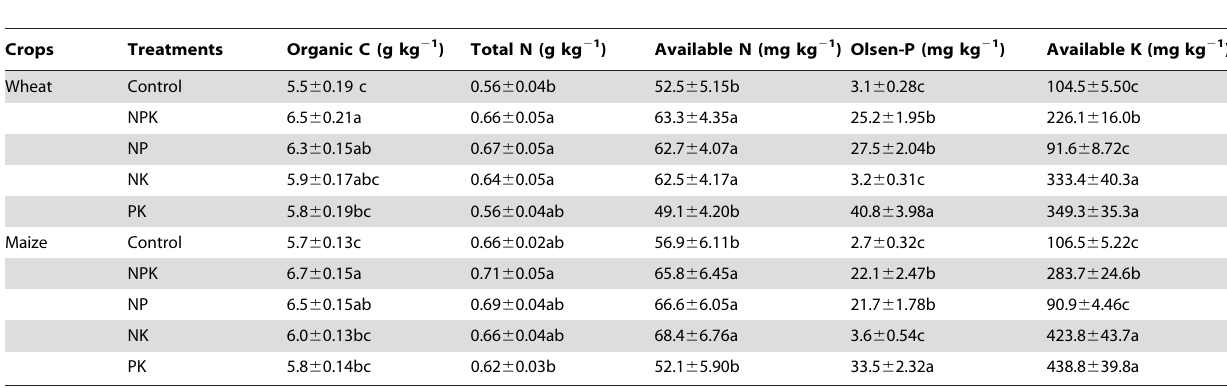
Table 4. Multi-year average soil nutrient status at wheat and maize harvest, as affected by various treatments with fertilizer in a wheat-maize rotation system at Yucheng, Shandong Province of China (mean 6 standard error).